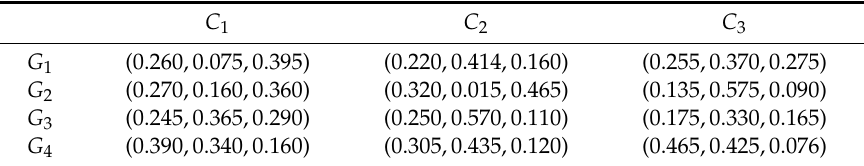
Table 10. Air quality data from station O 3 .